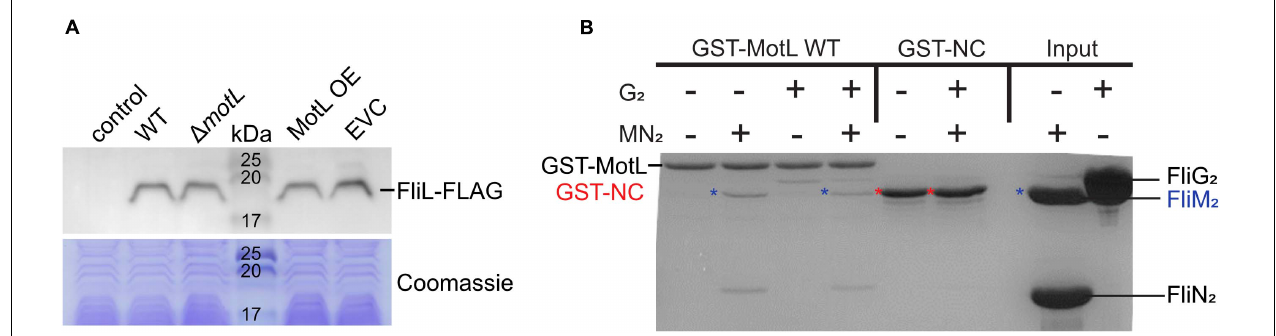
FIGURE 5 | Effect of MotL on FliL levels and MotL interaction with the flagellar C-ring. (A ) Western blot to determine the levels of (FLAG-tagged) FliL in dependence of MotL levels (upper panel) with the Coomassie-stained polyacrylamide gel as loading control in the panel below. Neither deletion nor overproduction of MotL affects FliL levels. (B ) Coomassie-stained gel of a GST pulldown with an immobilized MotL protein against the components of the lateral flagellar C-ring (proteins FliG 2 , FliM 2 , and FliN 2 ). GST alone (GST-NC) served as the negative control. The position of the proteins in the gel is indicated at the sides of the gel, in addition, blue asterisks indicate the position of FliM2 and red asterisks indicate those of